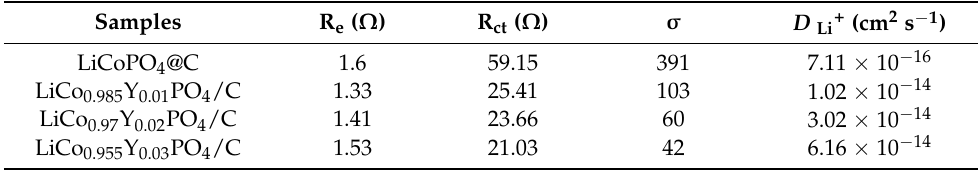
Figure 10. The EIS spectra of ( a ) the four electrodes and ( b ) the linear relationship between Z ′ and ω − 1/2 in four electrodes. Table 4. Impedance parameters of the four